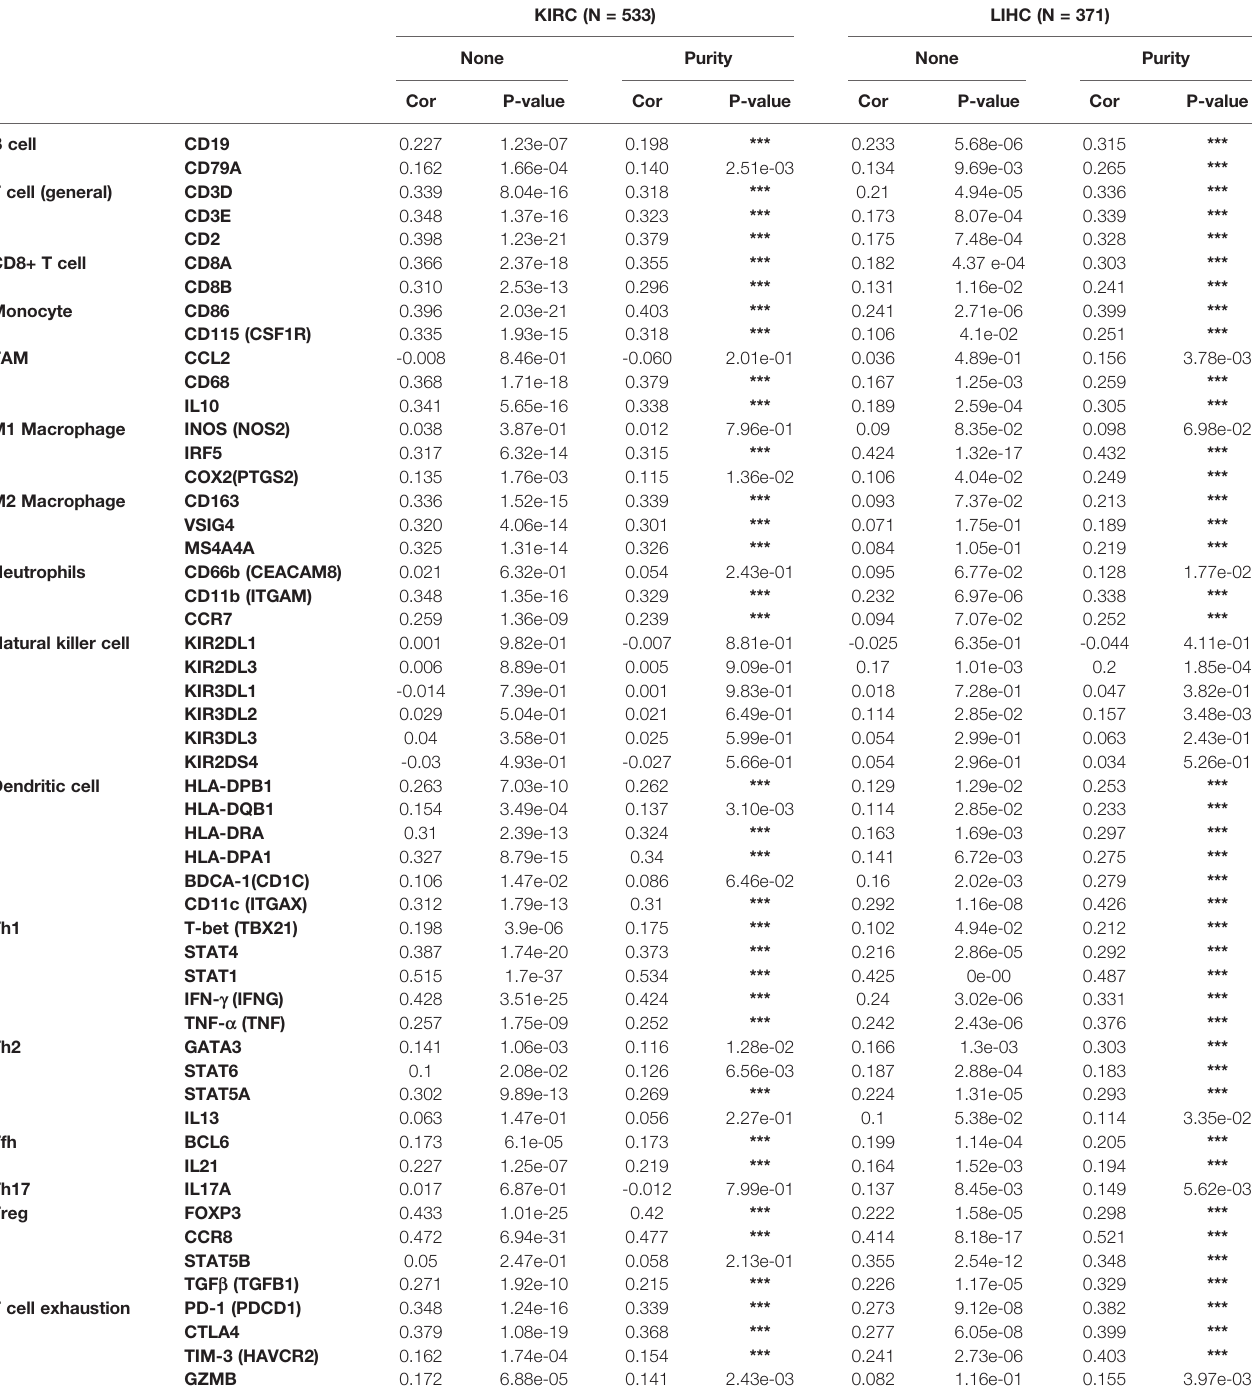
TABLE 2 | The correlation between ASPM expression level and immune cell in fi ltration in KIRC and LIHC using the TIMER database. KIRC (N = 533) LIHC (N = 371) None Purity None Purity Cor P-value Cor P-value Cor P-value Cor P-value B